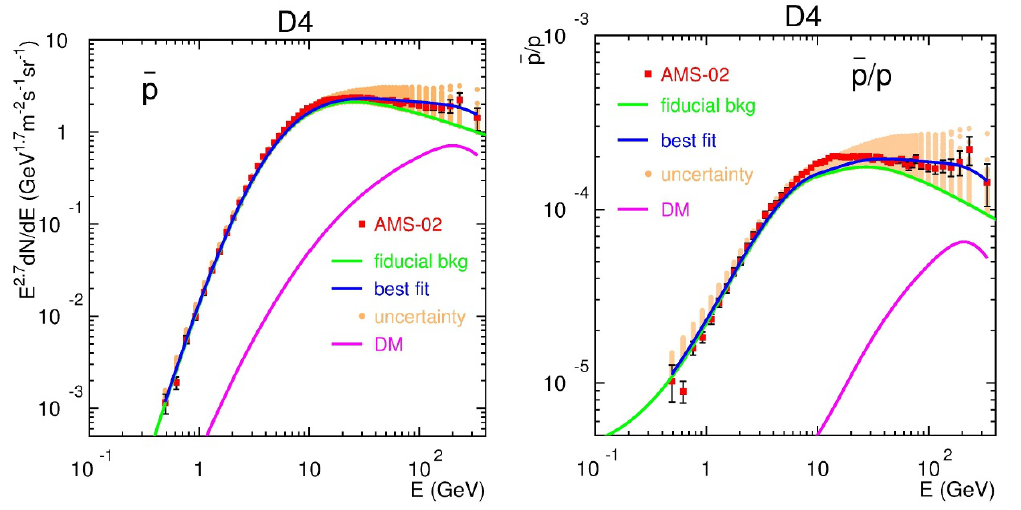
Figure 2 . Antiproton (cid:13)ux (left) and antiproton-to-proton ratio (right) observed by AMS-02 (red dots and dark error bars) in the simpli(cid:12)ed dark matter model D 4 .